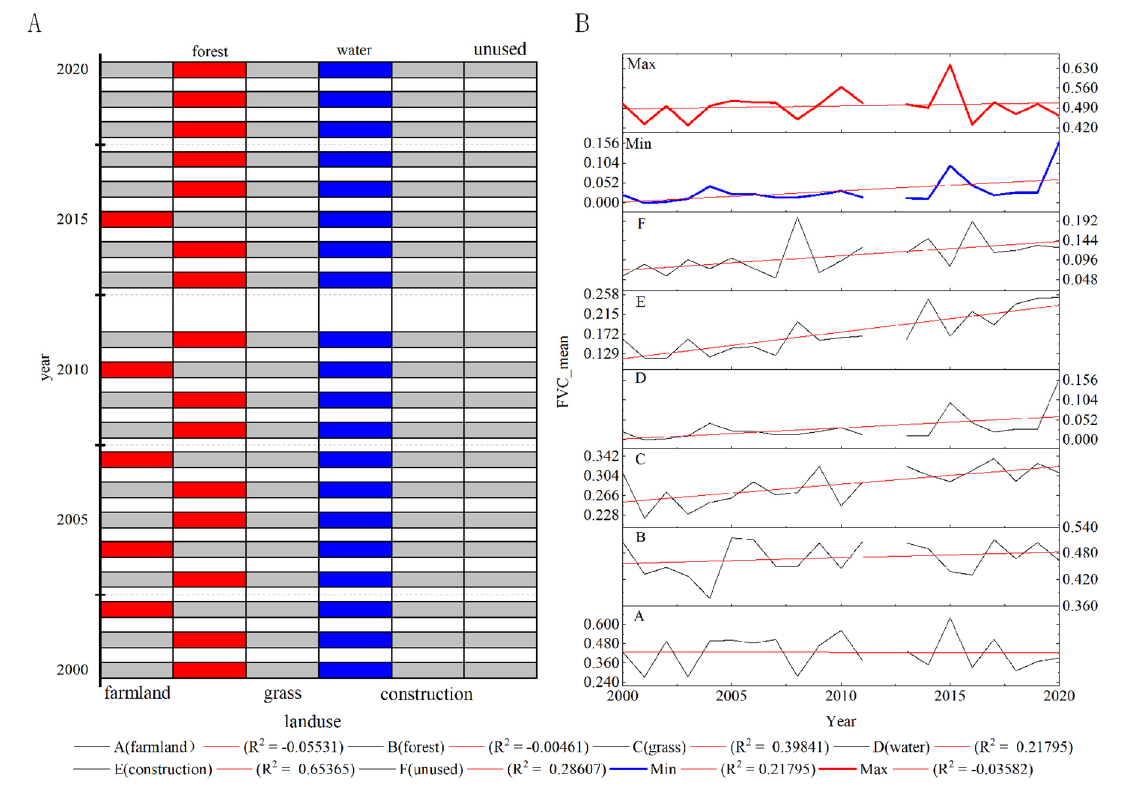
Figure 13. Analysis of the land use risk area based on the OPGD model: ( A ) land use type risk areas; ( B ) FVC mean values for each land use type risk areas; (red line) maximum FVC mean value in risk area; (blue line) minimum FVC mean value in risk area.